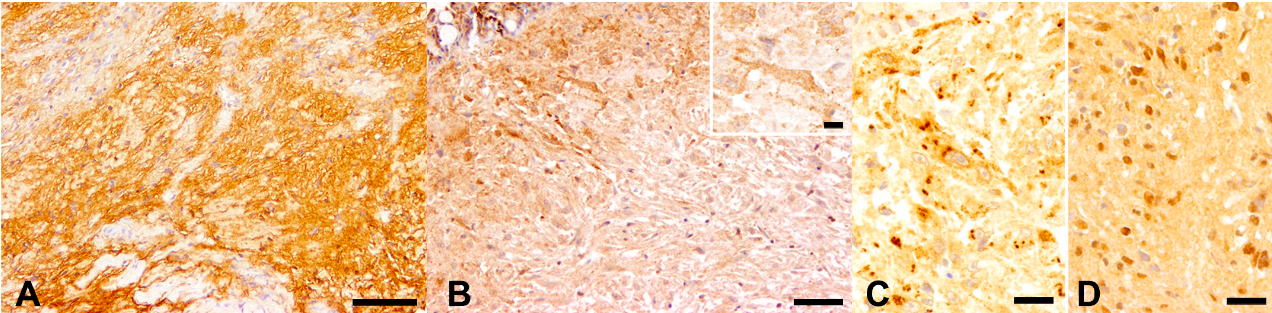
Figure 3. Immunohistochemistry (IHC) of atypical neurofibroma, skin, goldfish. ( A ) Case 1: Patchy distributed neoplastic cells with a cytoplasmic expression of S100 protein. IHC for S100 protein. ( B ) Case 2: Variable numbers of neoplastic cells with a membranous to cytoplasmic expression of CNPase (insert). Positive cells were mostly located in the superficial dermis, progressively reducing in number towards the bottom part of each nodule. IHC for CNPase. ( C , D ) Tumor cells displaying variably distributed positivity for non-phosphorylated neurofilaments ( C , Case 2) and scattered positivity for phosphorylated neurofilaments ( D , Case 4). IHC for non-phosphorylated ( C ) and phosphorylated ( D ) neurofilaments, focal cytoplasmic immunolabeling. Scale bars: 100 µm ( A ), 50 µm ( B ), 20 µm ( C , D ), 10 µm (B insert).